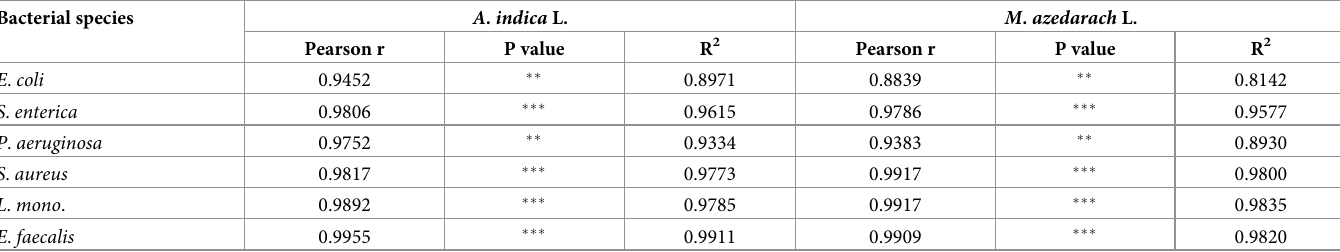
Table 4. Correlation between different doses of A . indica and M . azedarach extracts and log of persisted bacterial cells. Bacterial